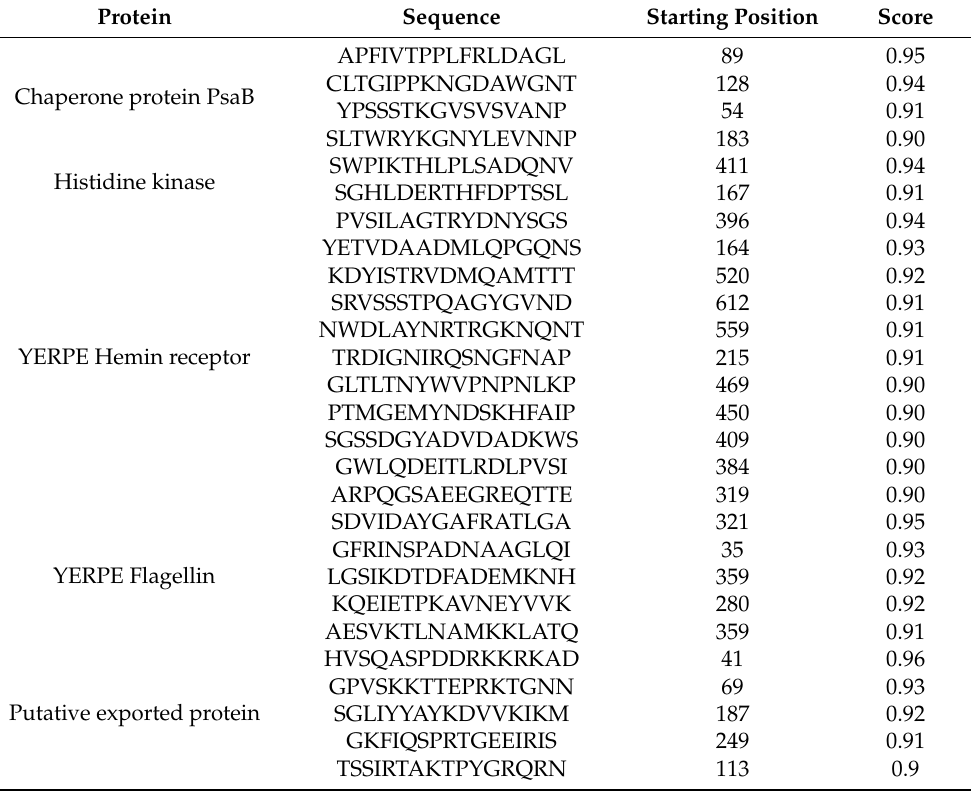
Table 4. Predicted B-cell epitopes, along with their scores and sequence information.